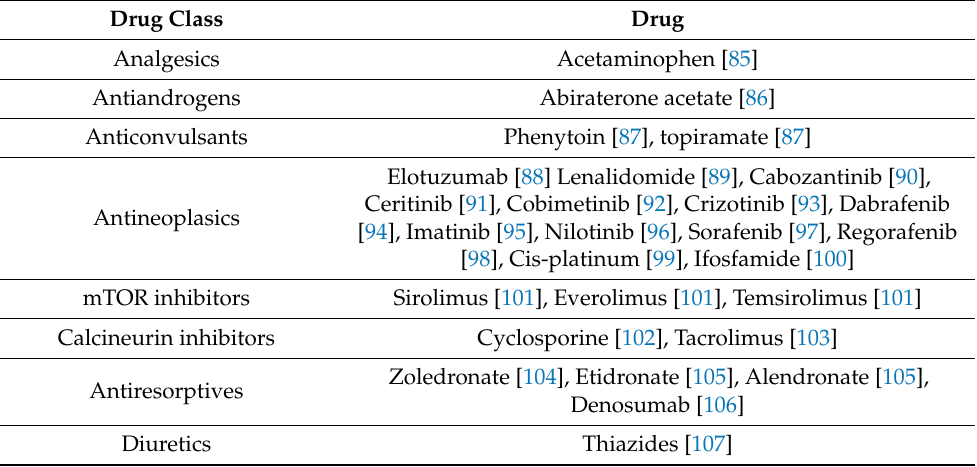
Table 4. Drugs that can cause hypophosphatemia (nonexhaustive